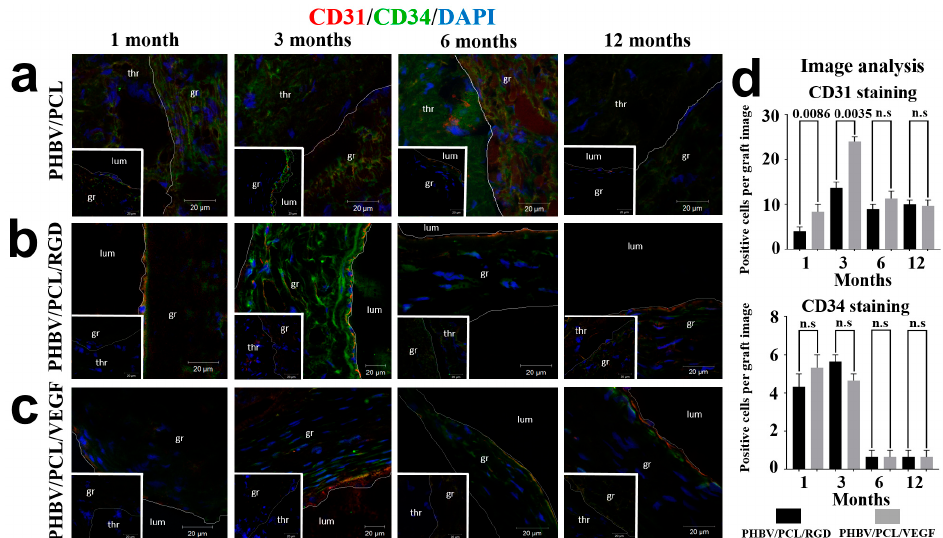
Figure 3. Combined CD31 (red), CD34 (green), and 4 ′ ,6-diamidino-2-phenylindole (DAPI, blue) staining. Representative images of: ( a ) PHBV/PCL grafts; ( b ) PHBV/PCL/RGD grafts; ( c ) PHBV/PCL/VEGF grafts. Thr is for thrombus, gr is for graft, lum is for lumen. Images of corresponding patent PHBV/PCL along with occluded PHBV/PCL/RGD and PHBV/PCL/VEGF grafts are presented as bottom inserts; ( d ) Quantitative image analysis, data are represented as mean with range, p -values are reported in a numerical manner, n.s. is for not significant, two-tailed Student’s t -test. Non-modified PHBV/PCL grafts were not included into analysis, since they were devoid of CD31 + and CD34 + cells.